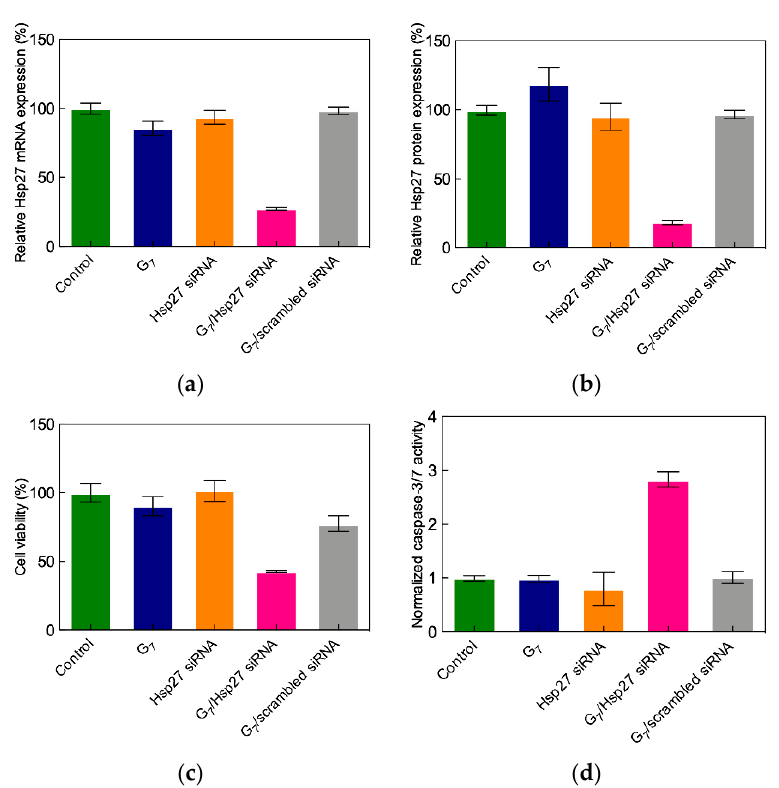
Figure 6. Quantitative analysis of ( a ) Hsp27 mRNA levels (determined by quantitative reverse transcription polymerase chain reaction (RT-qPCR)), ( b ) Hsp27 protein expression (determined by western blot analysis), ( c ) cell proliferation (determined by the 3-(4,5-dimethylthiazol-2-yl)-2,5-diphenyl tetrazolium bromide (MTT) assay), and ( d ) caspase-3/7 activity (measured by a colorimetric assay) in prostate cancer-3 (PC-3) cells three days after the TEA-core G 7 -mediated delivery of 50 nM Hsp27-targeting siRNA (N/P = 10) (hot pink bars in all panels). Data for dendrimer G 7 alone (blue bars), naked Hsp27 siRNA (orange bars), and scrambled siRNA–G 7 complexes (gray bars) are shown for comparison. Values are expressed as % relative to control (non-treated cells, green bars). Adapted from [42] with permission of John Wiley and Sons.